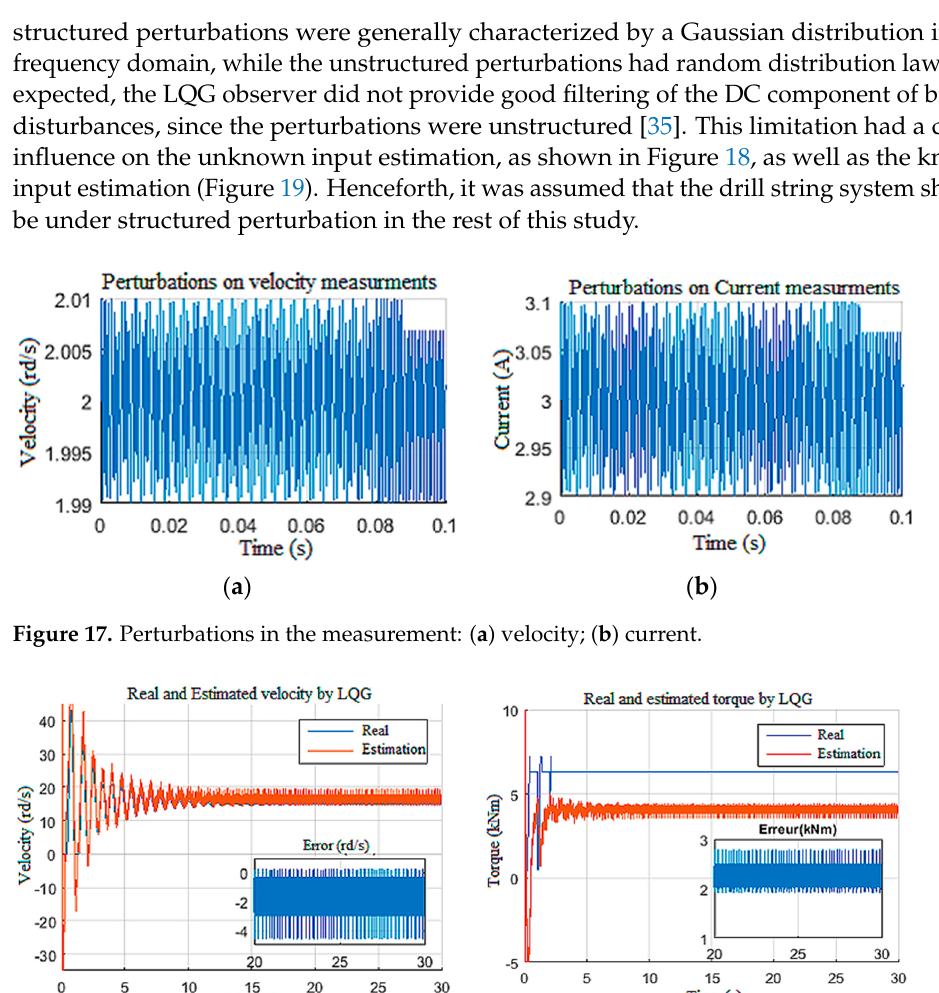
Figure 16. Top drive responses for Scenario 2: ( a ) velocity; ( b ) current.